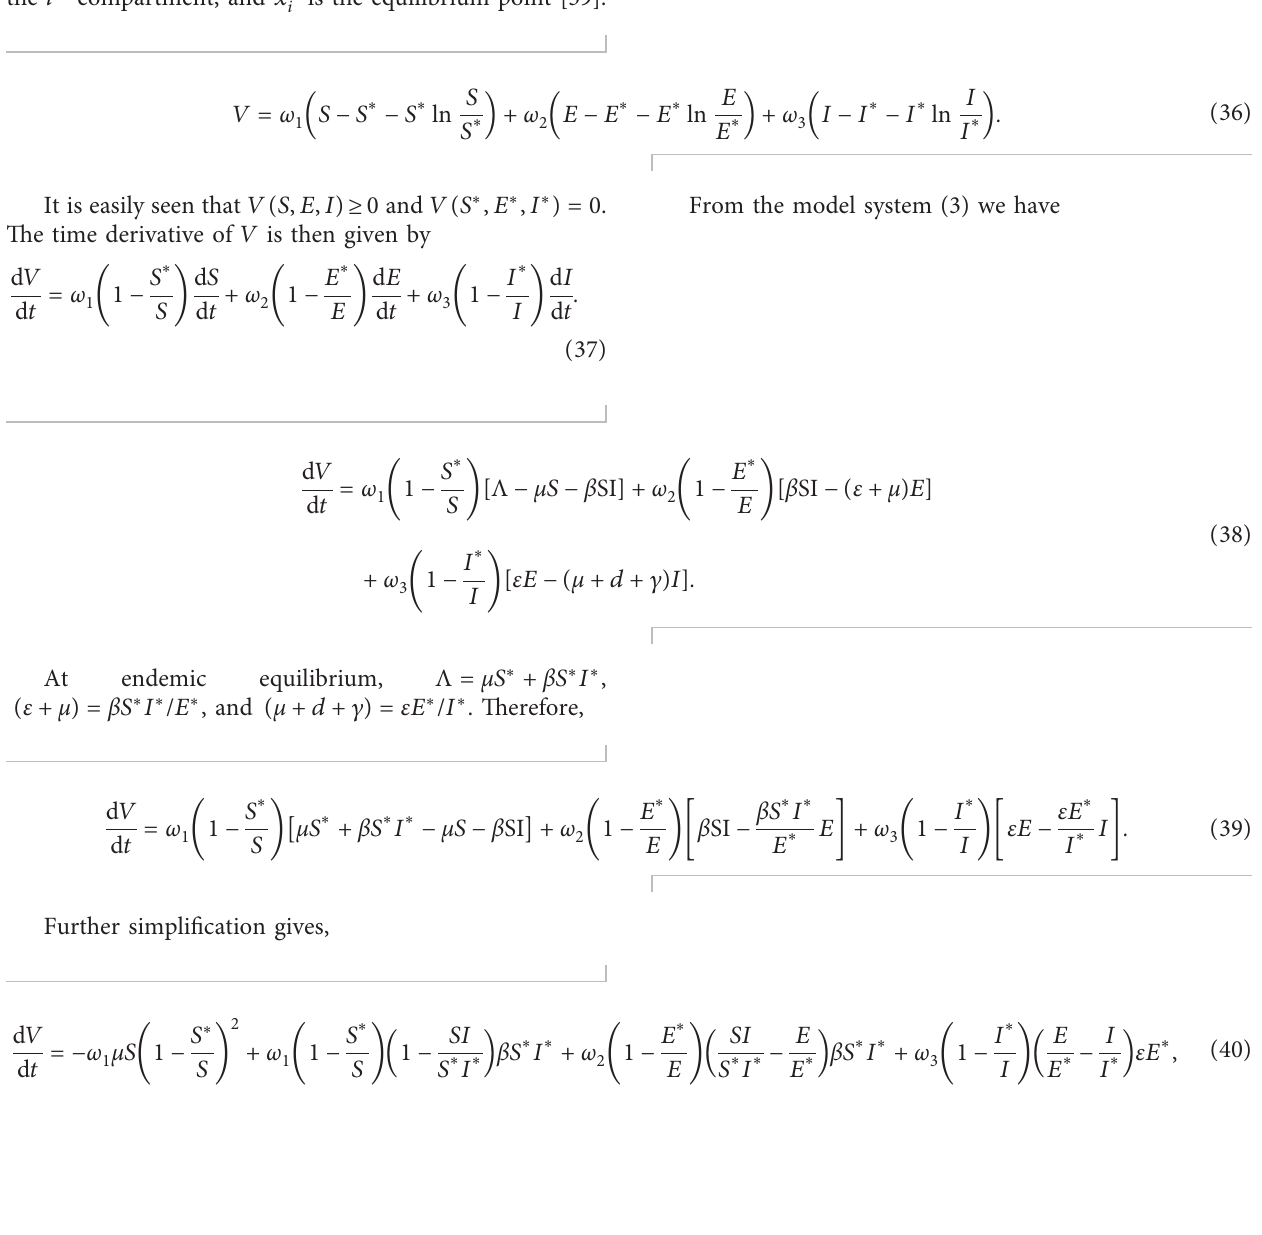
( v ) with β ( v ) and c ( v ) 0